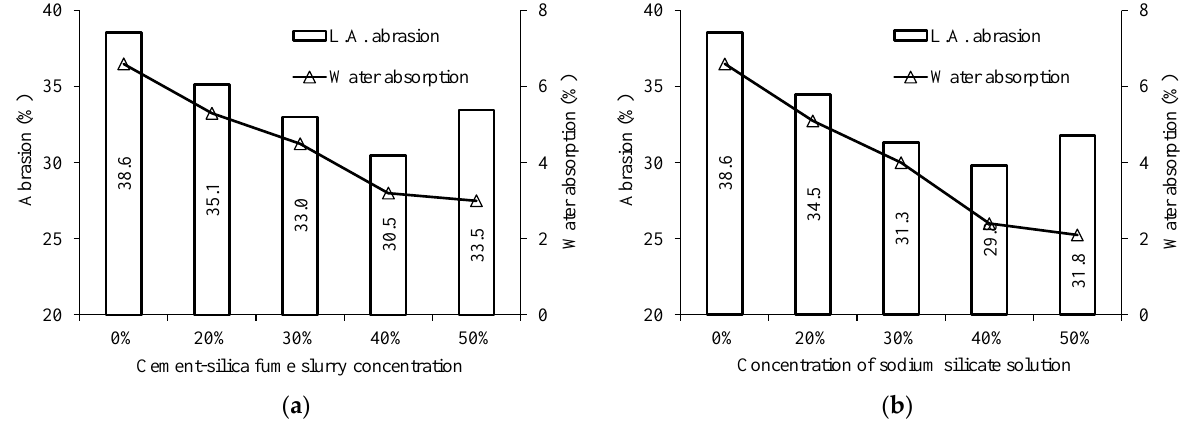
Figure 7. Water absorption and LA abrasion of RCA treated by: ( a ) method T1; and ( b ) method